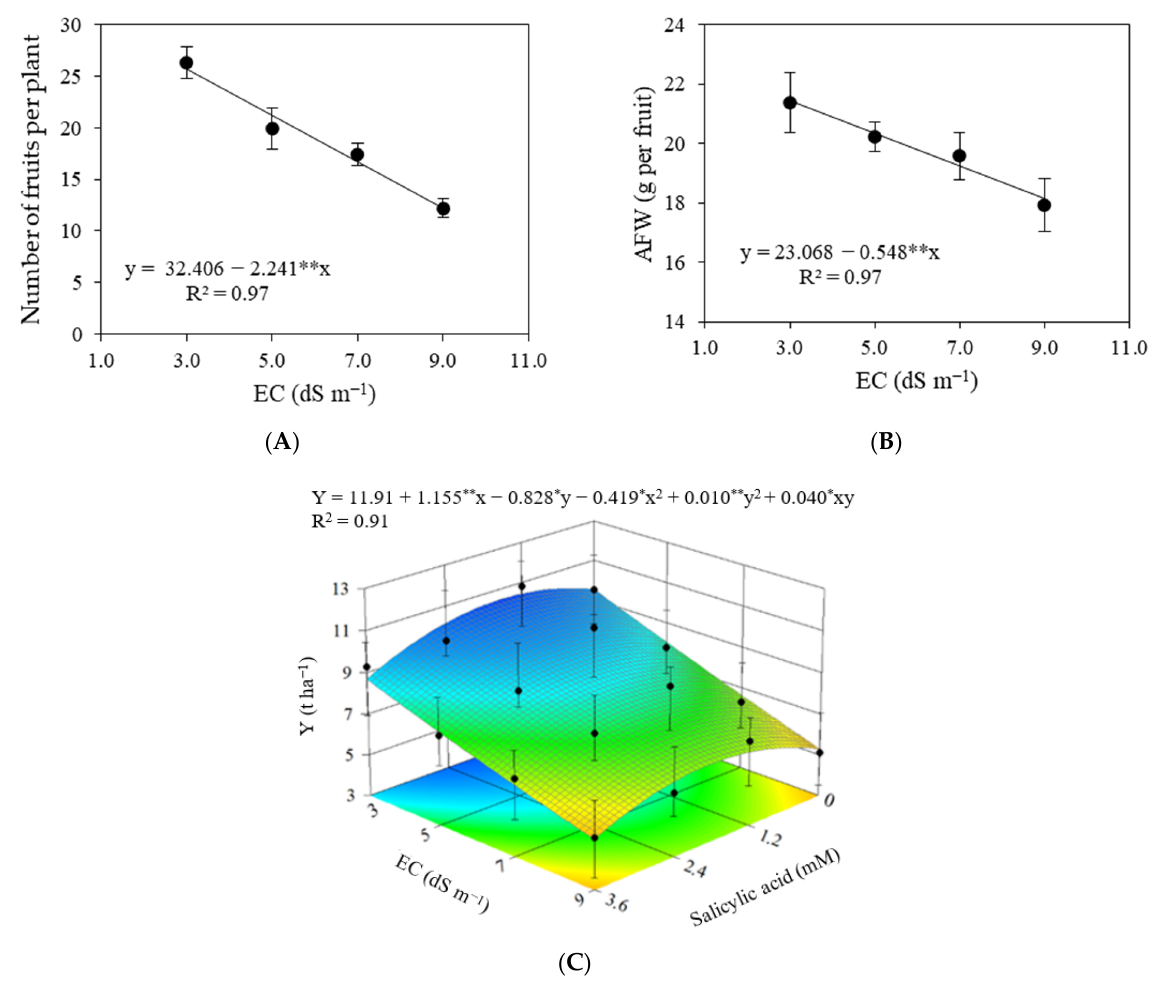
Figure 16. Number of fruits per plant—NFP ( A ) and average fruit weight—AFW of ‘Canindé’ okra grown in a hydroponic system as a function of the electrical conductivity of the nutrient solution—EC ( B ), and response surface for yield—Y ( C ) as a function of the interaction between EC and salicylic acid concentrations. X and Y—Concentration of salicylic acid and EC, respectively; * and ** significant at p ≤ 0.05 and ≤ 0.01, respectively. The vertical lines represent mean +/ − standard error (n = 4). Foliar application of salicylic acid at the concentration of 1.5 mM associated with an EC of 3.0 dS m − 1 promoted the highest value of yield (10.49 t ha − 1 ) in okra plants (Figure